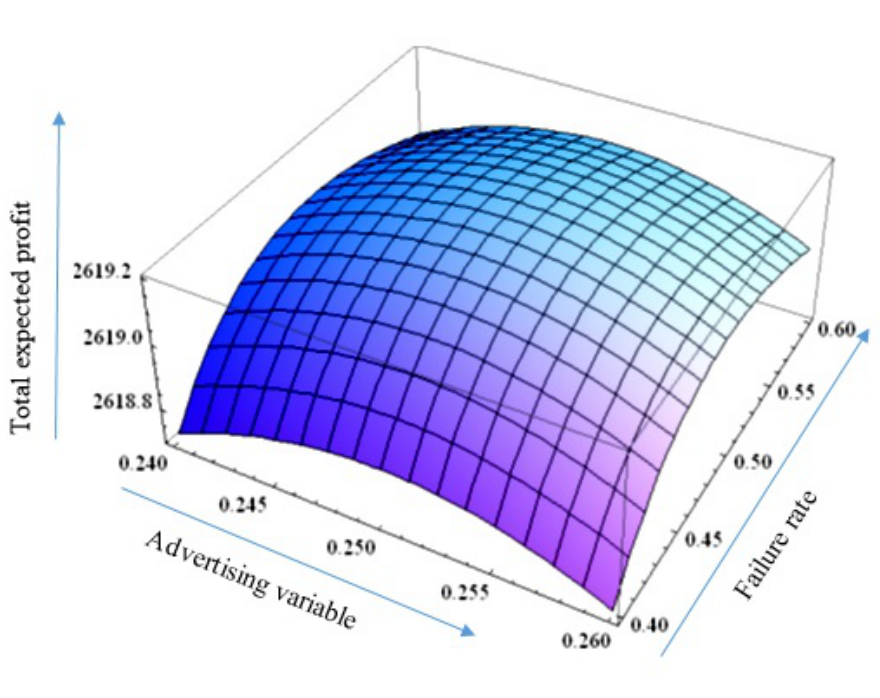
Figure 8. The total expected profit versus the selling price and the failure rate α .